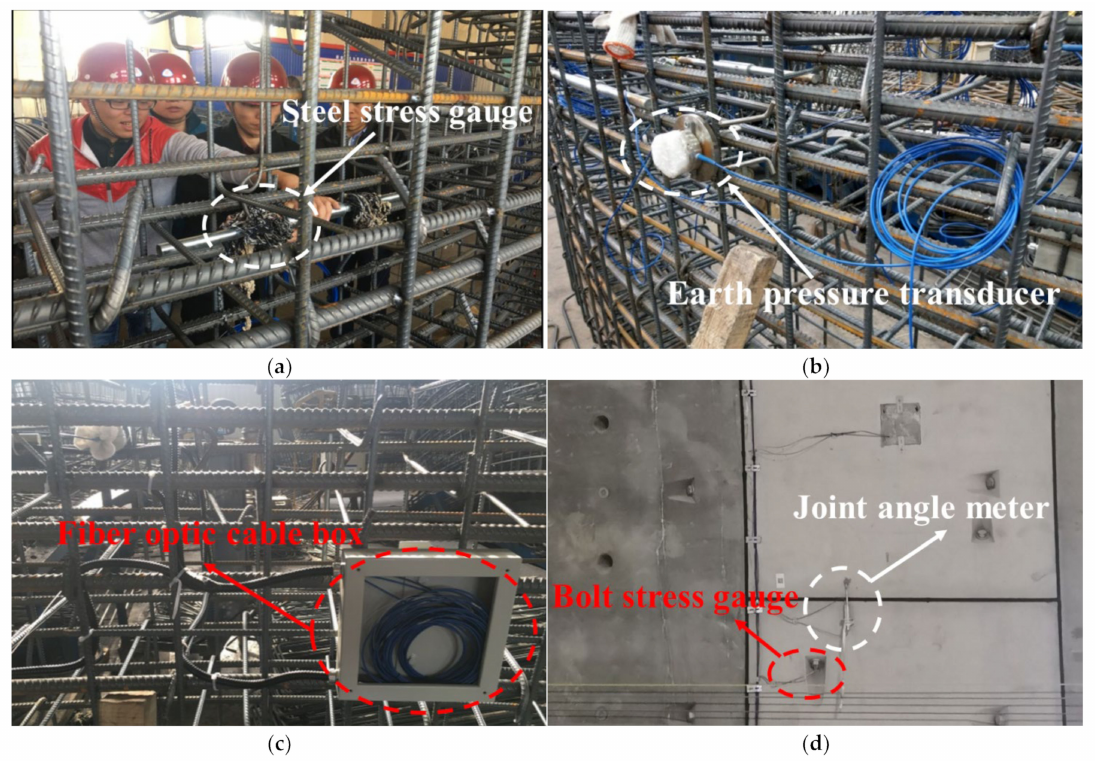
Figure 8. The on-site installation and layout. ( a ) Diagram of reinforcement gauge installation. ( b ) Installation diagram of the earth pressure box. ( c ) Fiber optic cable box. ( d ) Appearance of